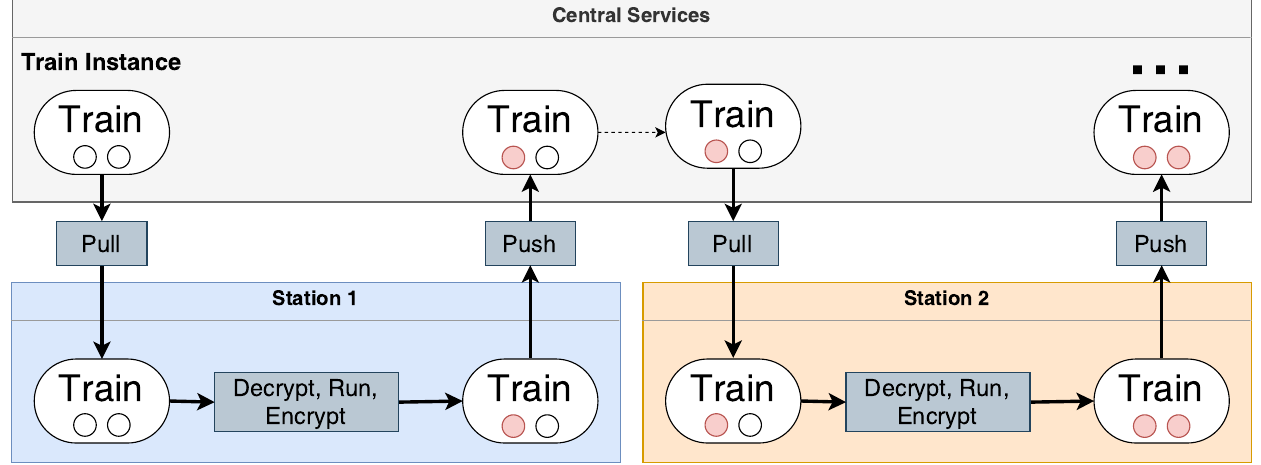
Figure 1. High-level overview of the PHT infrastructure. The Central Service (CS) orchestrates the so-called analysis train from station to station. Each station pulls the train from a dedicated repository in CS and executes the analysis after the decryption. After saving the results (red dots), the train is pushed back to the CS, and the same procedure happens for succeeding stations until the last station is